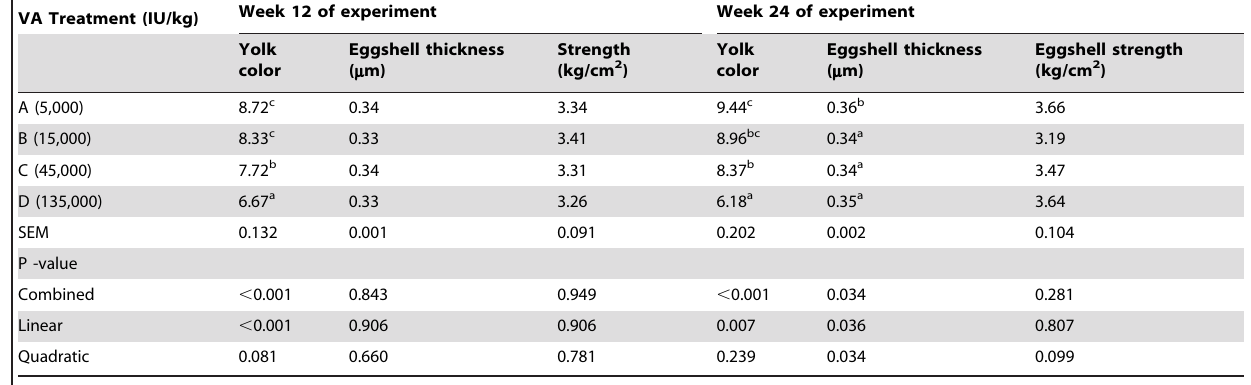
Table 4. Egg quality.